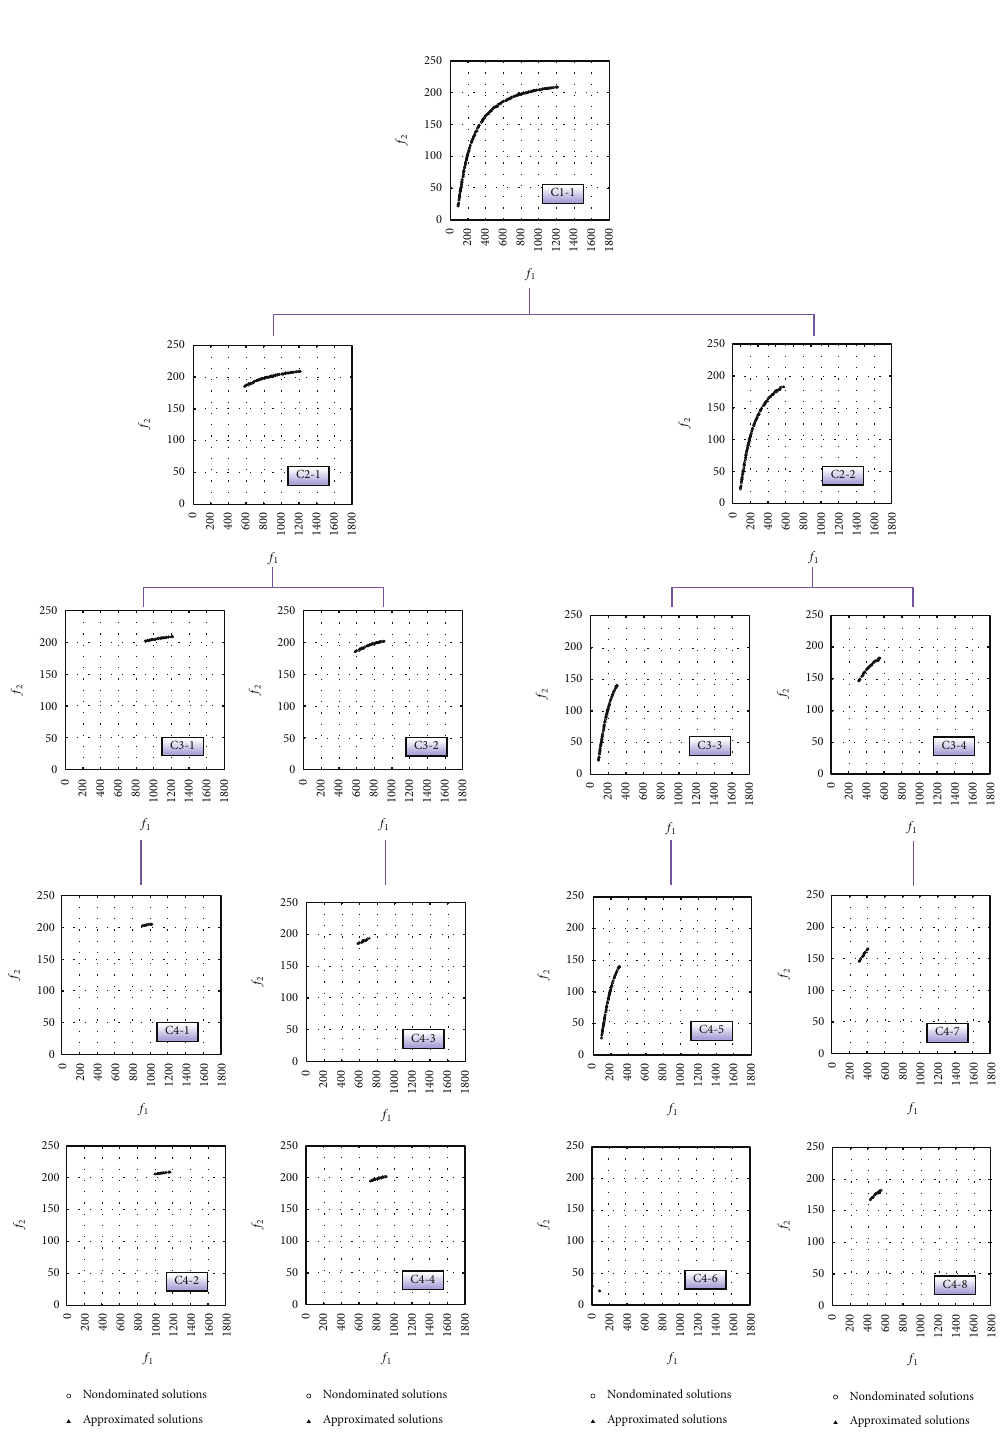
Figure 16: Approximated solutions of each cluster in each